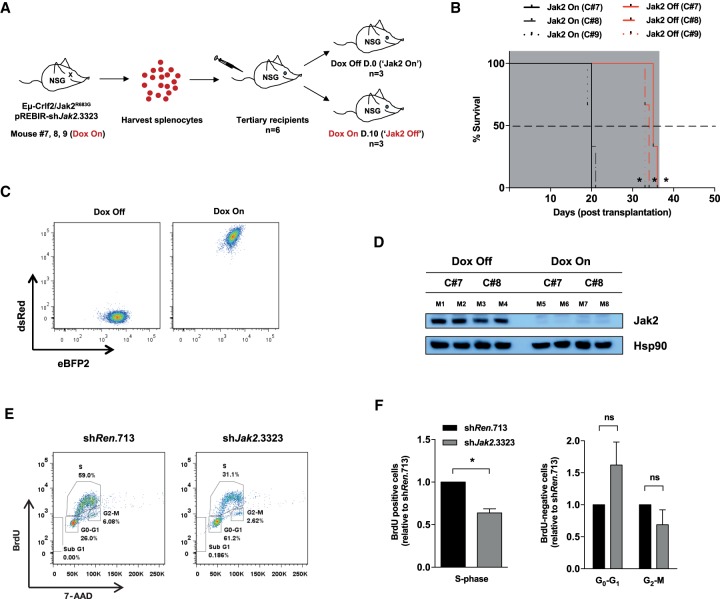
RNAi-mediated Jak2 depletion induces an anti-proliferative response independent of cell death in Eµ-Crlf2/Jak2R683G B-ALLs in vivo. (A) Schematic illustration of the experimental design. Splenocytes from moribund bound secondary recipients (mouse 7, mouse 8, and mouse 9 from recipients in Fig. 3F, referred to here as Jak2 knockdown-persistent clone 7 [C#7], clone 8 [C#8], and clone 9 [C#8]) of Eµ-Crlf2/Jak2R683G-pREBIR-shJak2.3323 (Dox on) leukemia cells were harvested and engrafted into tertiary recipient mice. n = 6 for each clone. For each clone, mice were left untreated (Dox off; n = 3) or treated with Dox (Dox on; n = 3) from day 0 after transplantation. (B) Kaplan-Meier survival curve of Dox-treated (Jak2 off; n = 3 per clone) and untreated (Jak2 on; n = 3 per clone) recipient mice of Jak2 knockdown-persistent Eµ-Crlf2/Jak2R683G-pREBIR-shJak2.3323 leukemia cells. Gray shading indicates the period of Dox administration. (C) Representative flow cytometric plot showing eBFP2/dsRed proportions of Jak2 knockdown-persistent Eµ-Crlf2/Jak2R683G-pREBIR-shJak2.3323 cells (GFP+) in the spleens of Dox-treated (Dox-on) and untreated (Dox-off) recipients in B at terminal disease. (D) Immunoblotting against the indicated targets was performed using lysates isolated from splenocytes of individual moribund bound Dox-treated (Dox on; eBFP2+/dsRed+ cells; M5–M8) and untreated (Dox off; eBFP2+/dsRed− cells; M1–M4) recipients in B. (E) Representative flow cytometric plot of BrdU incorporation and 7-AAD staining of eBFP2+/dsRed+ splenocytes from recipients of Eμ-Crlf2/Jak2R683G-pREBIR-shRenilla.713 (shRen.713) and Eμ-Crlf2/Jak2R683G-pREBIR-shJak2.3323 B-ALLs (shJak2.3323) at 48 h after in vivo shRNA induction. (F) Quantification of S-, G0/G1-, and G2M-phase cell percentages of cell cycle analysis from Figure 6E. Error bars represent SEM (n = 2) performed in triplicate (three independent mice). (*) P < 0.05; (ns) nonsignificant (P > 0.05).